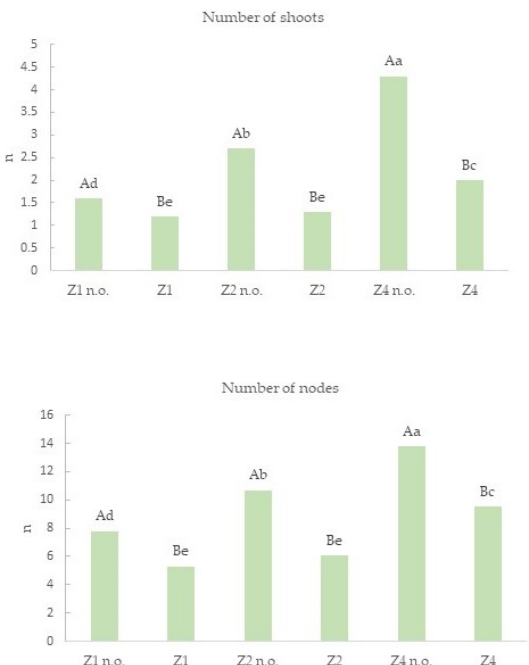
Figure 1. Number ( n ) of shoots and nodes produced by each initial explant. The values followed by a different capital letter are statistically different according to Duncan’s test ( p ≤ 0.05) for each treatment with the same zeatin concentration; the values followed by a different small letter are statistically different in the comparison of all treatments.